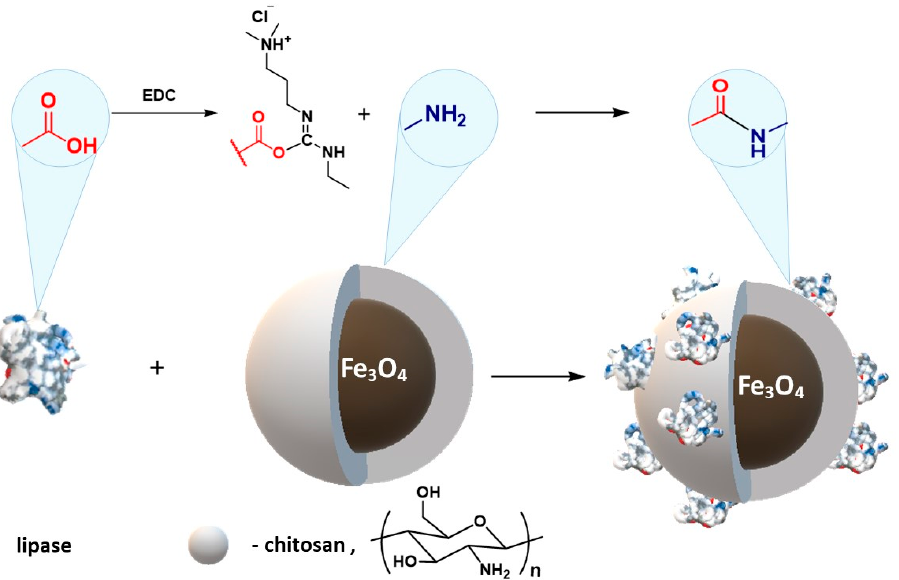
Figure 16. Scheme of lipase immobilization on the magnetic nanoparticles (MNPs) surface using 1-ethyl-3-(3-dimethyl-aminopropyl) carbodiimide (EDC)/sulfo- N -hydroxysuccinimide (NHS).